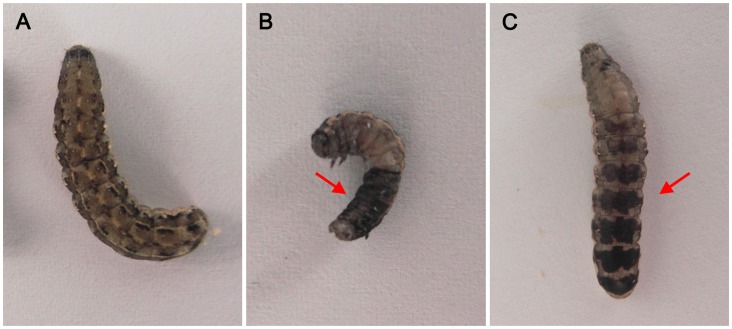
Developmental defects in siRNA-treated individuals.(A) Larvae in the negative control group injected with siRNAs with a random sequence. (B) The “half-ecdysis” in chitinase1-siRNA and chitinase7-siRNA groups. The photo was taken 24 h after siRNA injection. Red arrow indicates the part of larval body still in the old cuticle. This larva could not complete ecdysis and eventually died. (C) The “black body” in arf1-siRNA and arf2-siRNA groups. The photo was taken 72 h after siRNA injection. Red arrow indicates black color in the body.